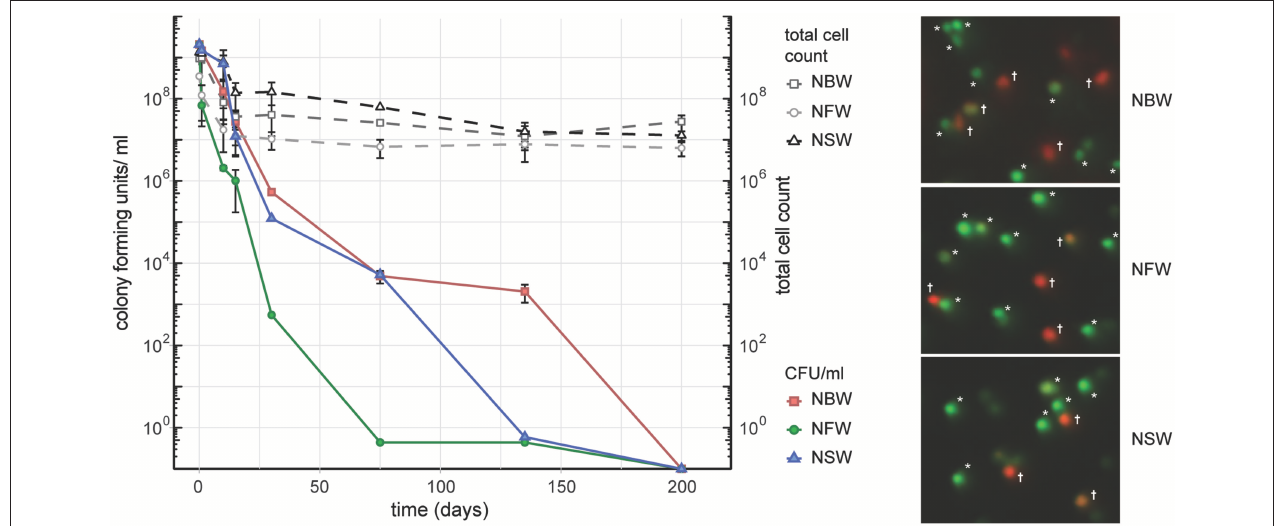
FIGURE 1 | Cell number, colony forming units (CFU) and viability during VBNC formation. Left panel shows the CFU/ ml and total cells count of V. cholerae incubated in natural brackish (NBW), fresh (NFW) or salt water (NSW). Right panel shows examples of the live/ dead staining using propidium iodide and Syto9. Cells marked with an asterisk were counted as “live” while cells with yellow, orange or red hue (marked with a cross) are deemed